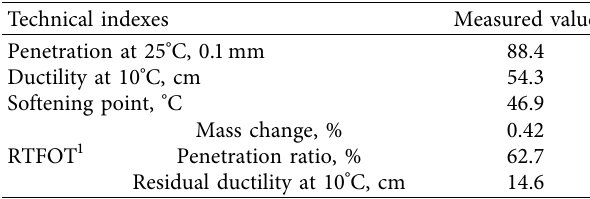
Table 1: Technical indexes of KLMY 90# asphalt.